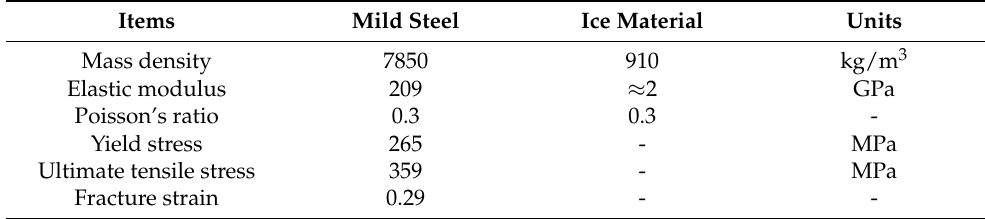
Figure 2. Stress-strain curves for the mild steel: ( a ) Engineering stress-strain curve obtained by Quasi-static tensile test and true stress-strain curve obtained by the ’combined material’ relation; ( b ) Dynamic true stress-strain curve obtained by the Cowper-Symonds constitutive model. Table 1. Mechanical properties of mild steel and ice